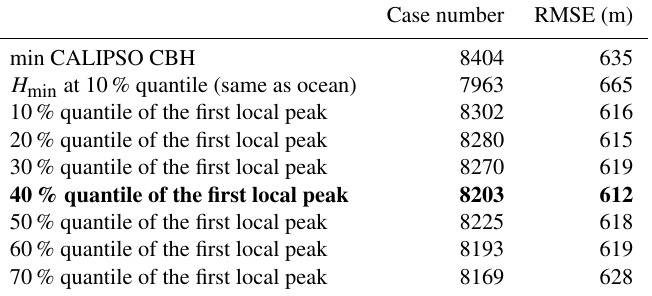
Table B1. Validation statistics of CALIPSO-retrieved initial CBH for different conditions of 138 continental ceilometer sites in the southern Great Plains in 2017–2020. The values in bold are the retrieval criteria that we used over the land.